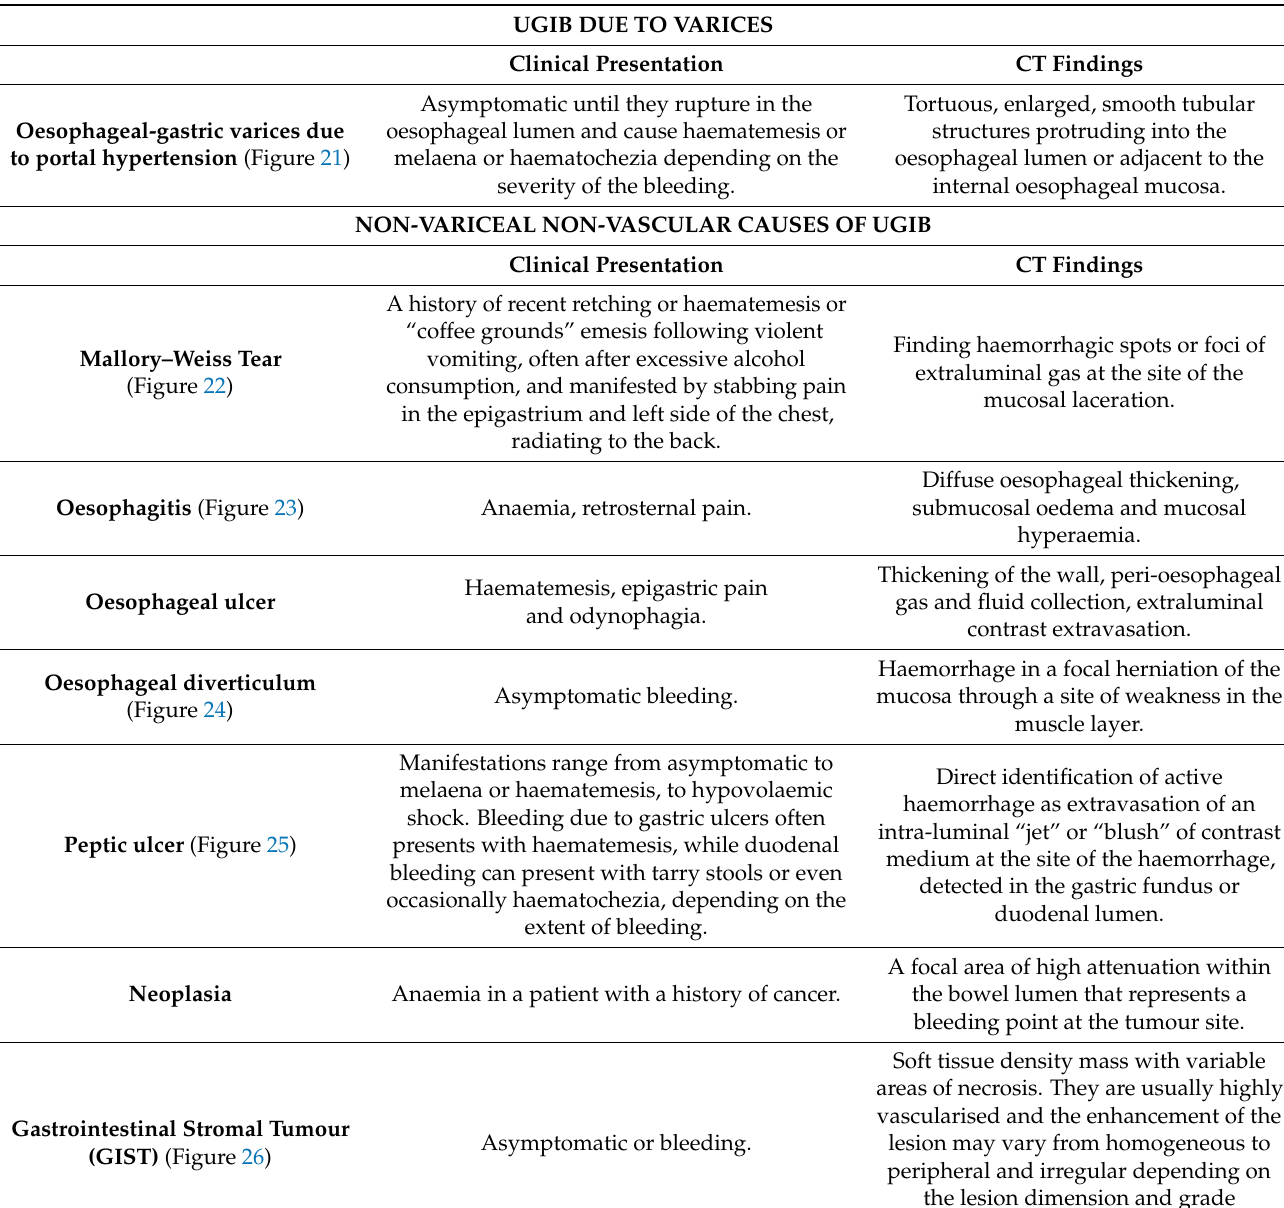
Table 5. Frequent causes of UGIB: clinical presentation and CT